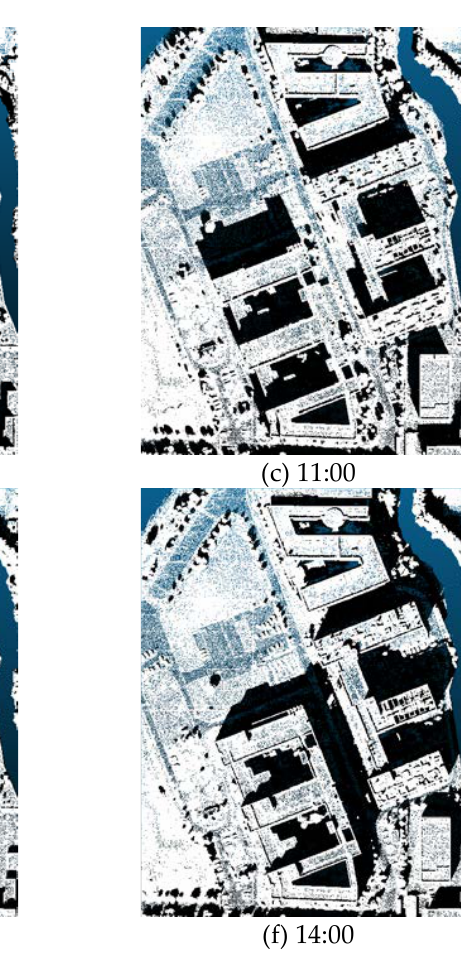
Figure 9. The calculated results of SVF.